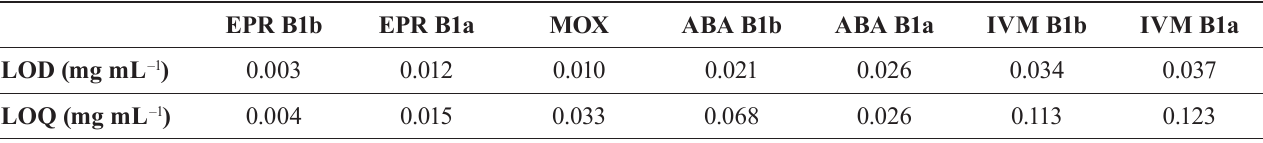
Table V and VI show the medium values of intra and interday for the different analytes, in which the precision was evaluated by RSD% and accuracy by RE%. Intraday precision values ranged between 0.321–1.859, and interday between 0.152–2.315.